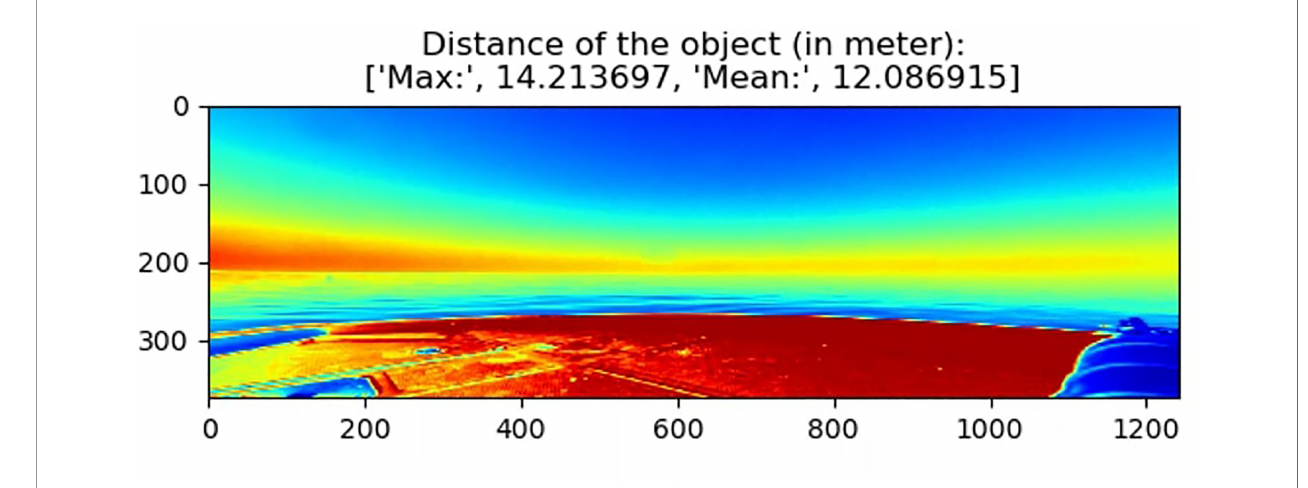
FIGURE 9 | Distance mapping from stereo